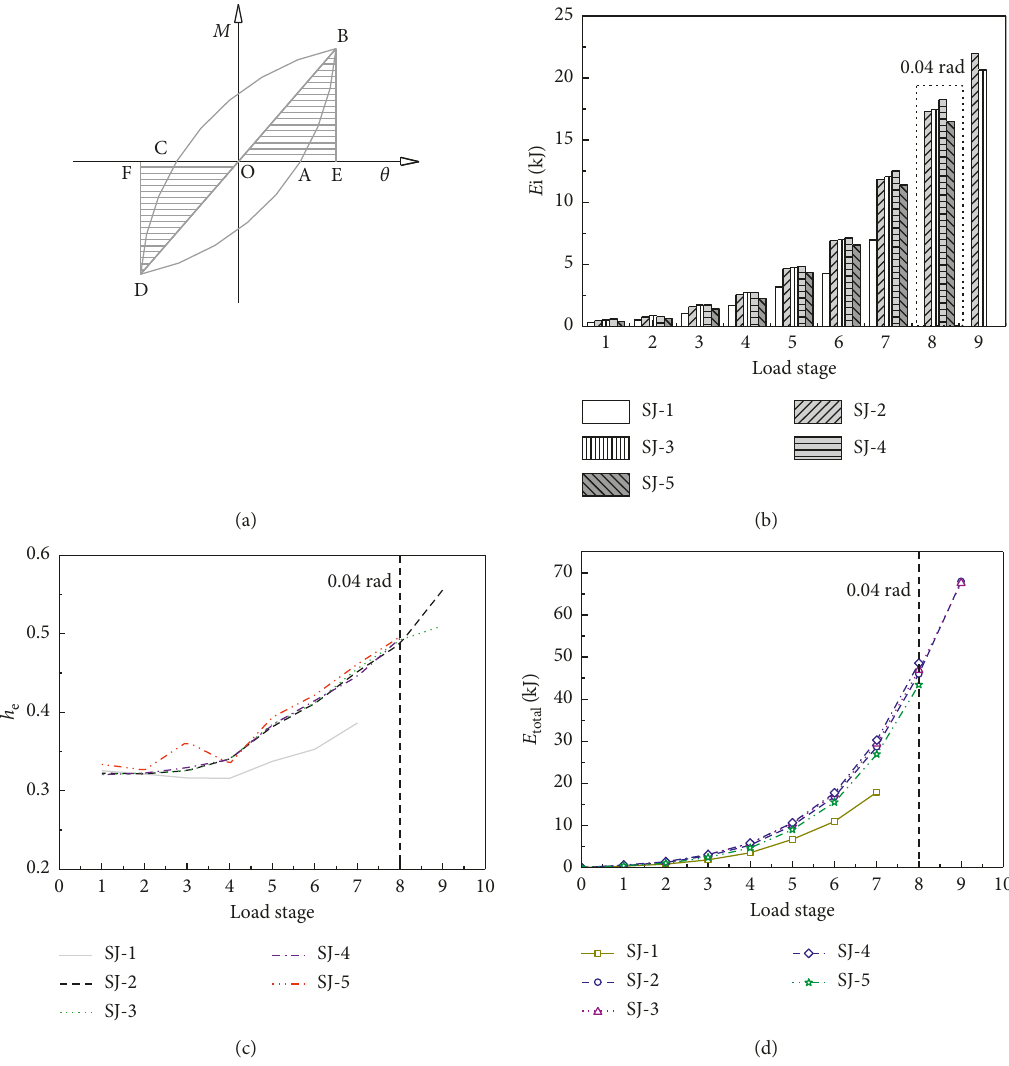
Figure 13: Comparison of energy dissipation and the hysteretic loop in the test specimens. (a) Definition of a hysteretic loop. (b) Energy dissipated during each step. (c) Equivalent viscous damping. (d) Accumulated energy dissipation.